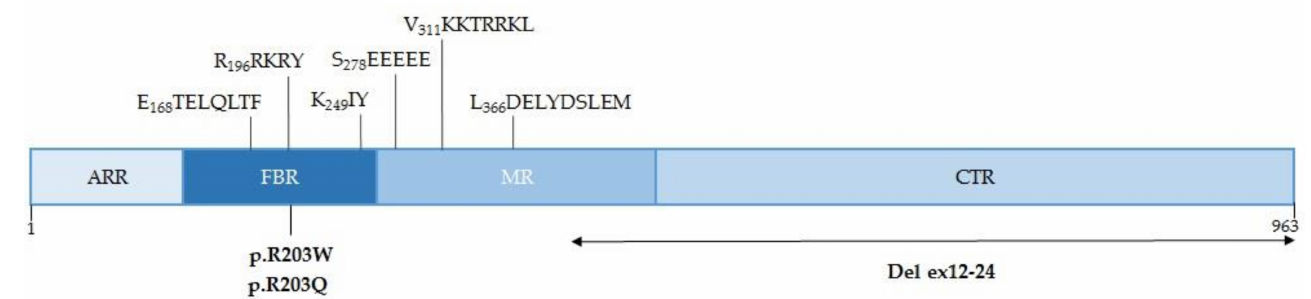
Figure 1. Schematic representation of the PACS-1 protein. Key sequences and pathological variants are located in the sequence. ARR, atrophin-1-related region; FBR, furin-binding region; MR, middle region; CTR, C -terminal